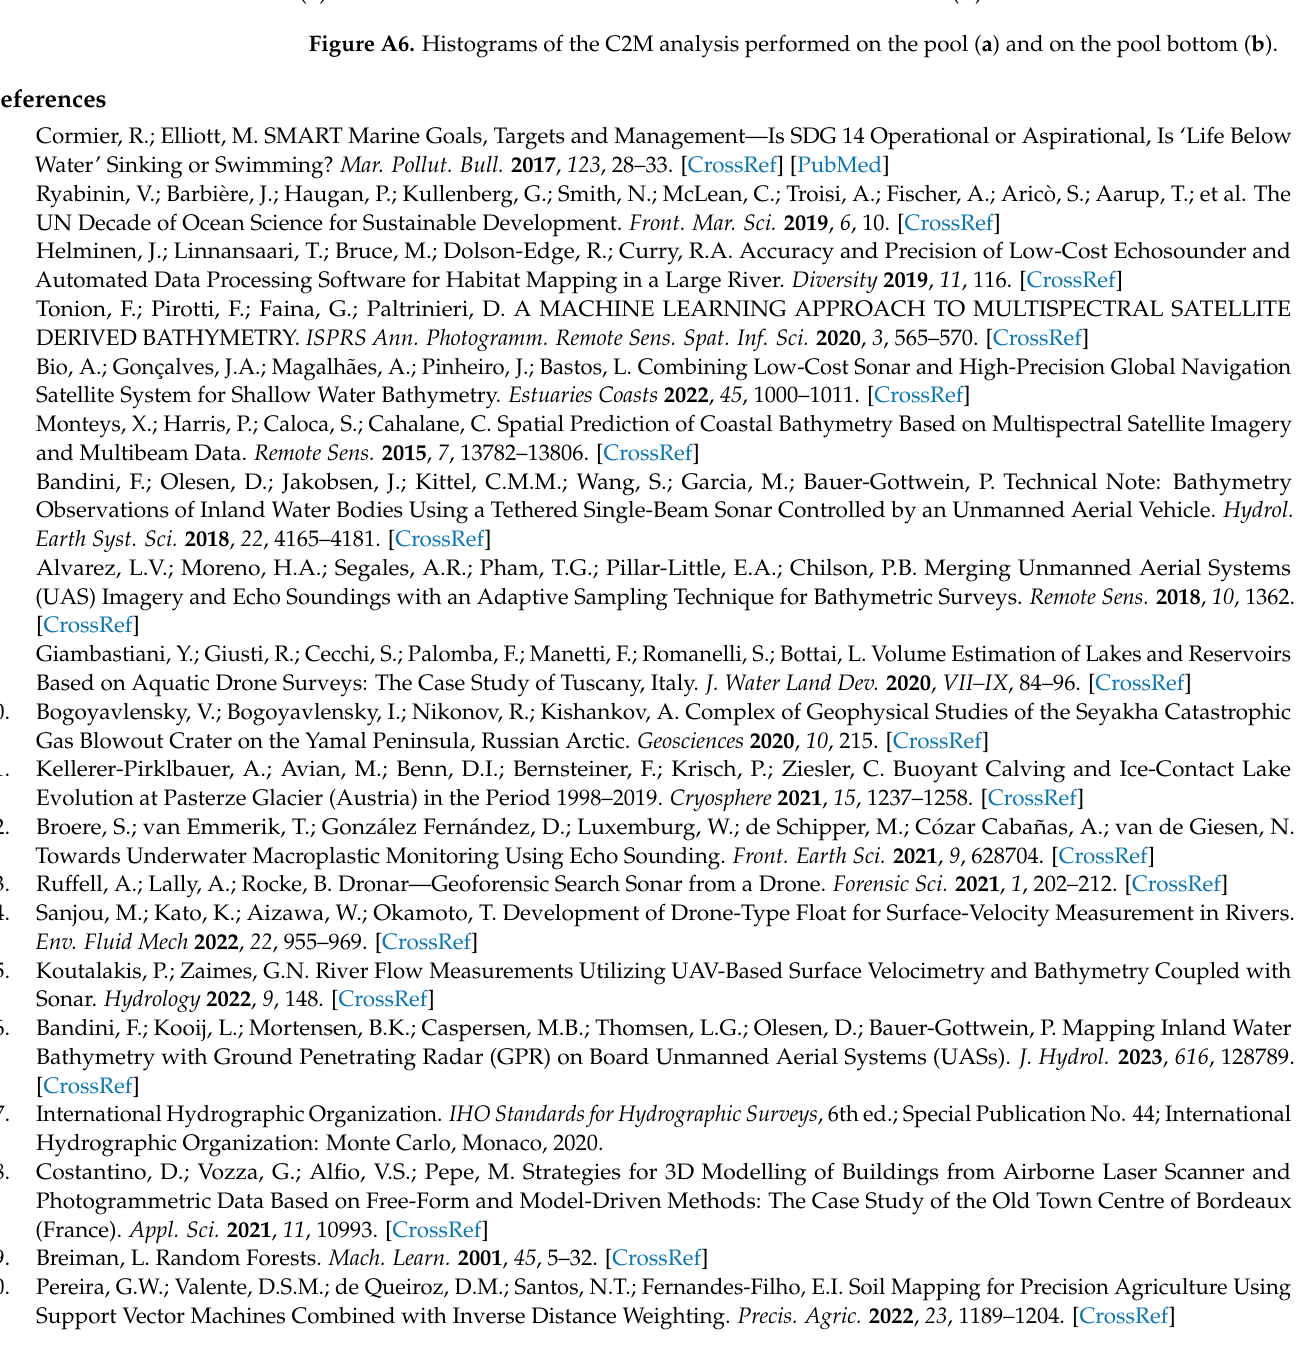
Figure A6. Histograms of the C2M analysis performed on the pool ( a ) and on the pool bottom ( b ).